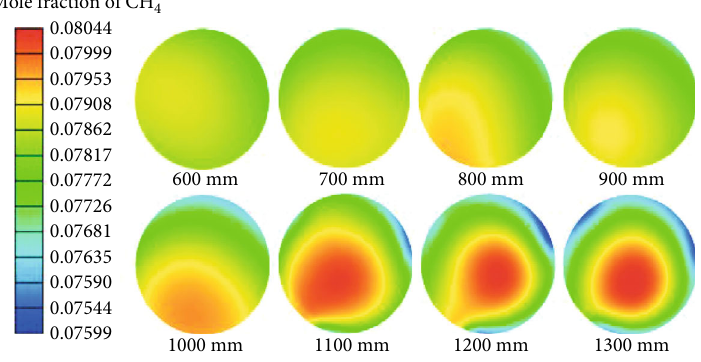
Figure 5: In fl uence of length of spiral blade on the uniformity in the mixing